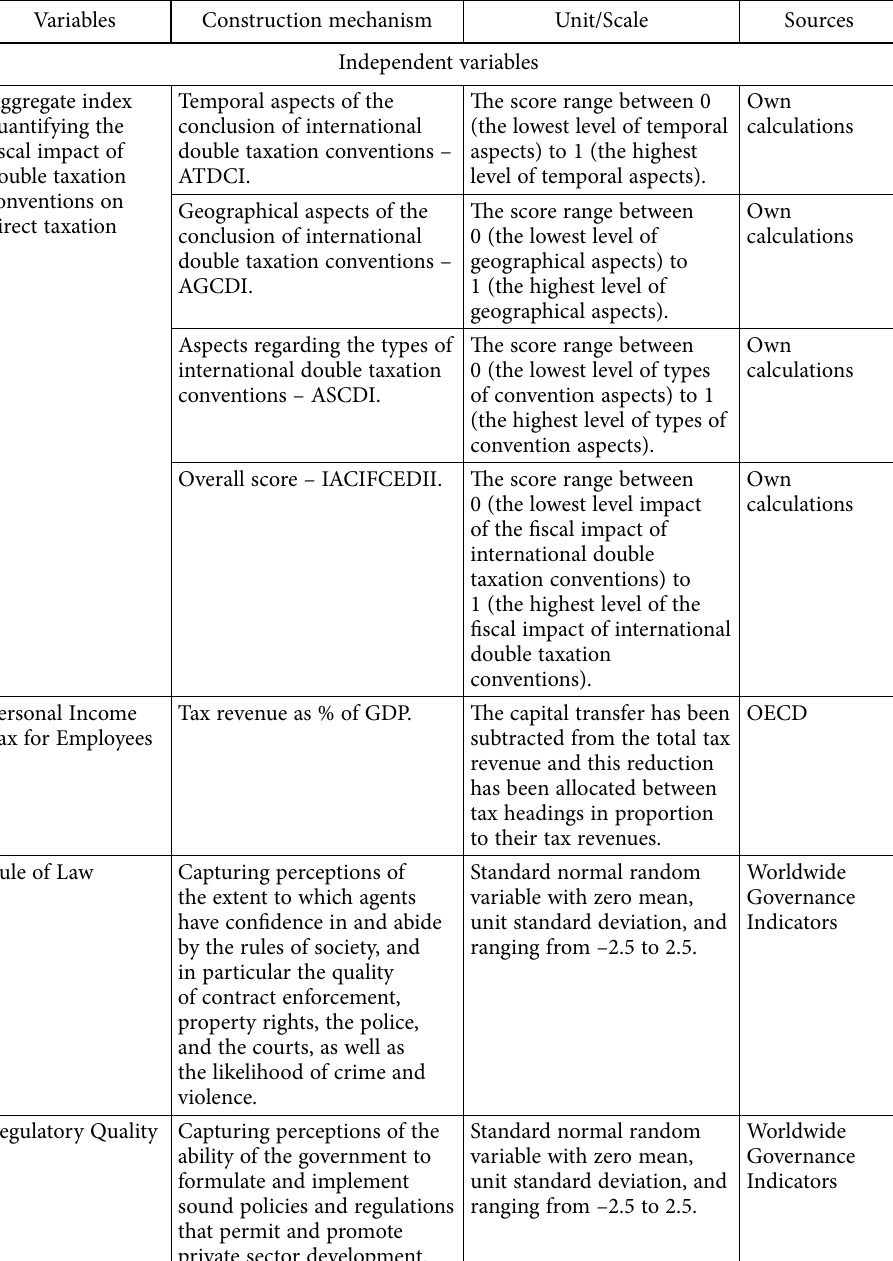
Table 4. Data and variables (source: own processing)